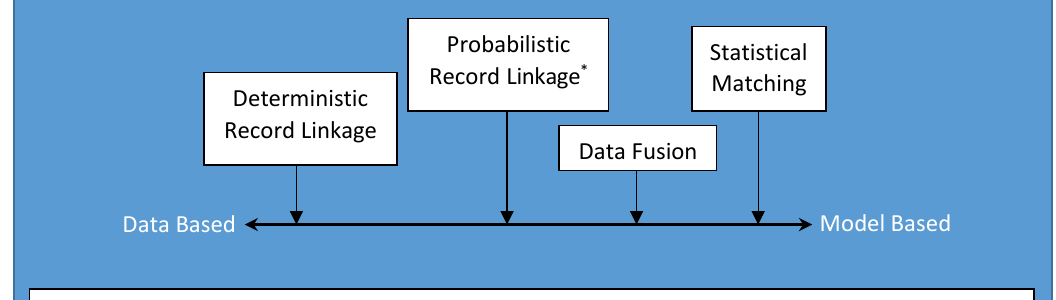
Figure 2. Ranking of data combination techniques from data based (deterministic) to model based (probabilistic).